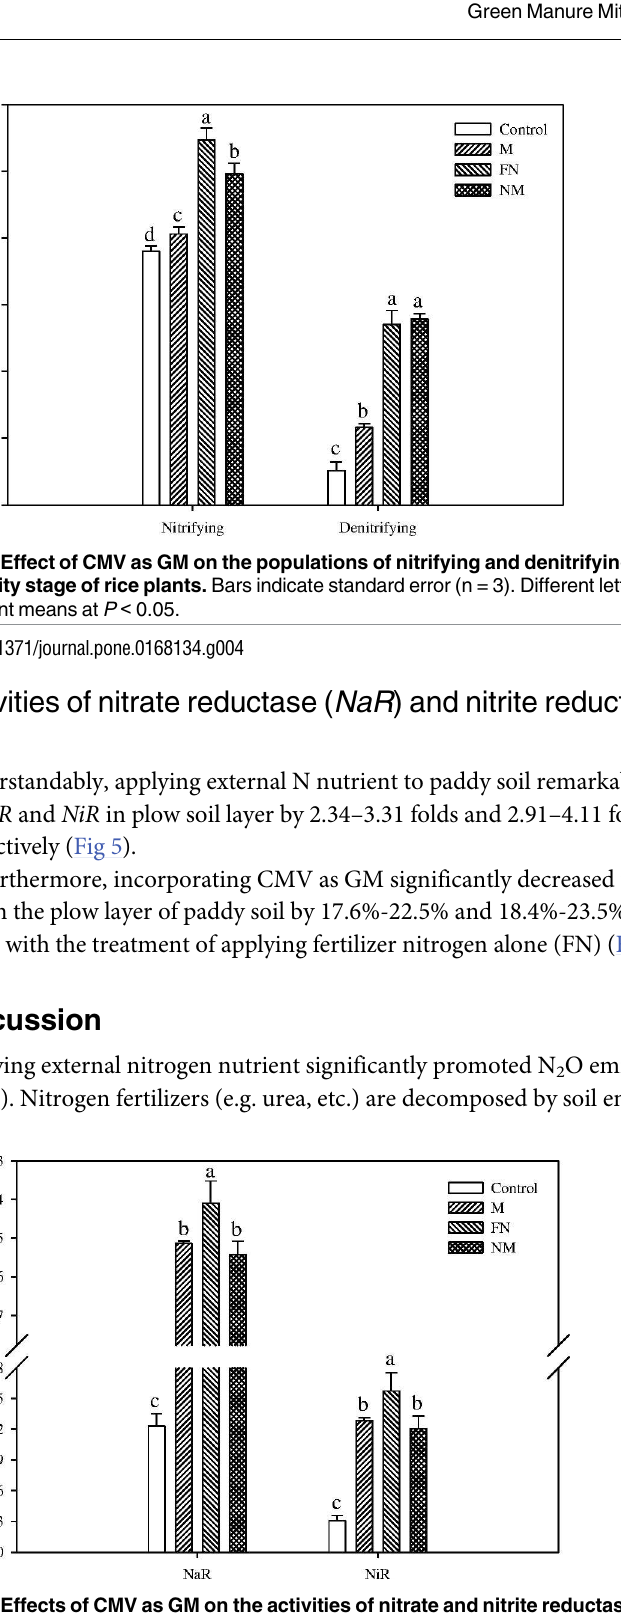
Fig 5. Effects of CMV as GM on the activities of nitrate and nitrite reductase in paddy soil at maturity stage of rice plants. Bars indicate standarderror (n = 3). Different letters indicatesignificantly different means at P <